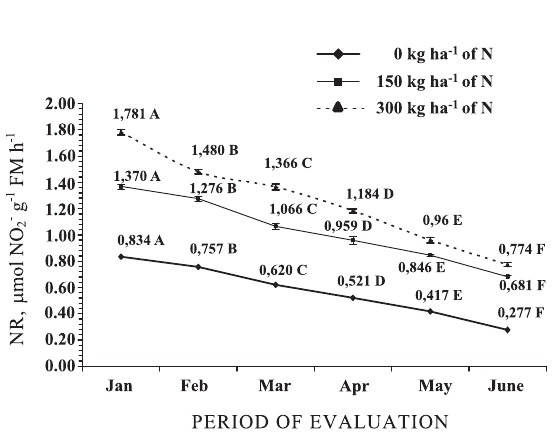
Figure 2. Nitrate reductase activity during fruit development, considering different N-rates (control, 150 and 300 kg ha -1 ). Means followed by the same letter do not differ by the Tukey